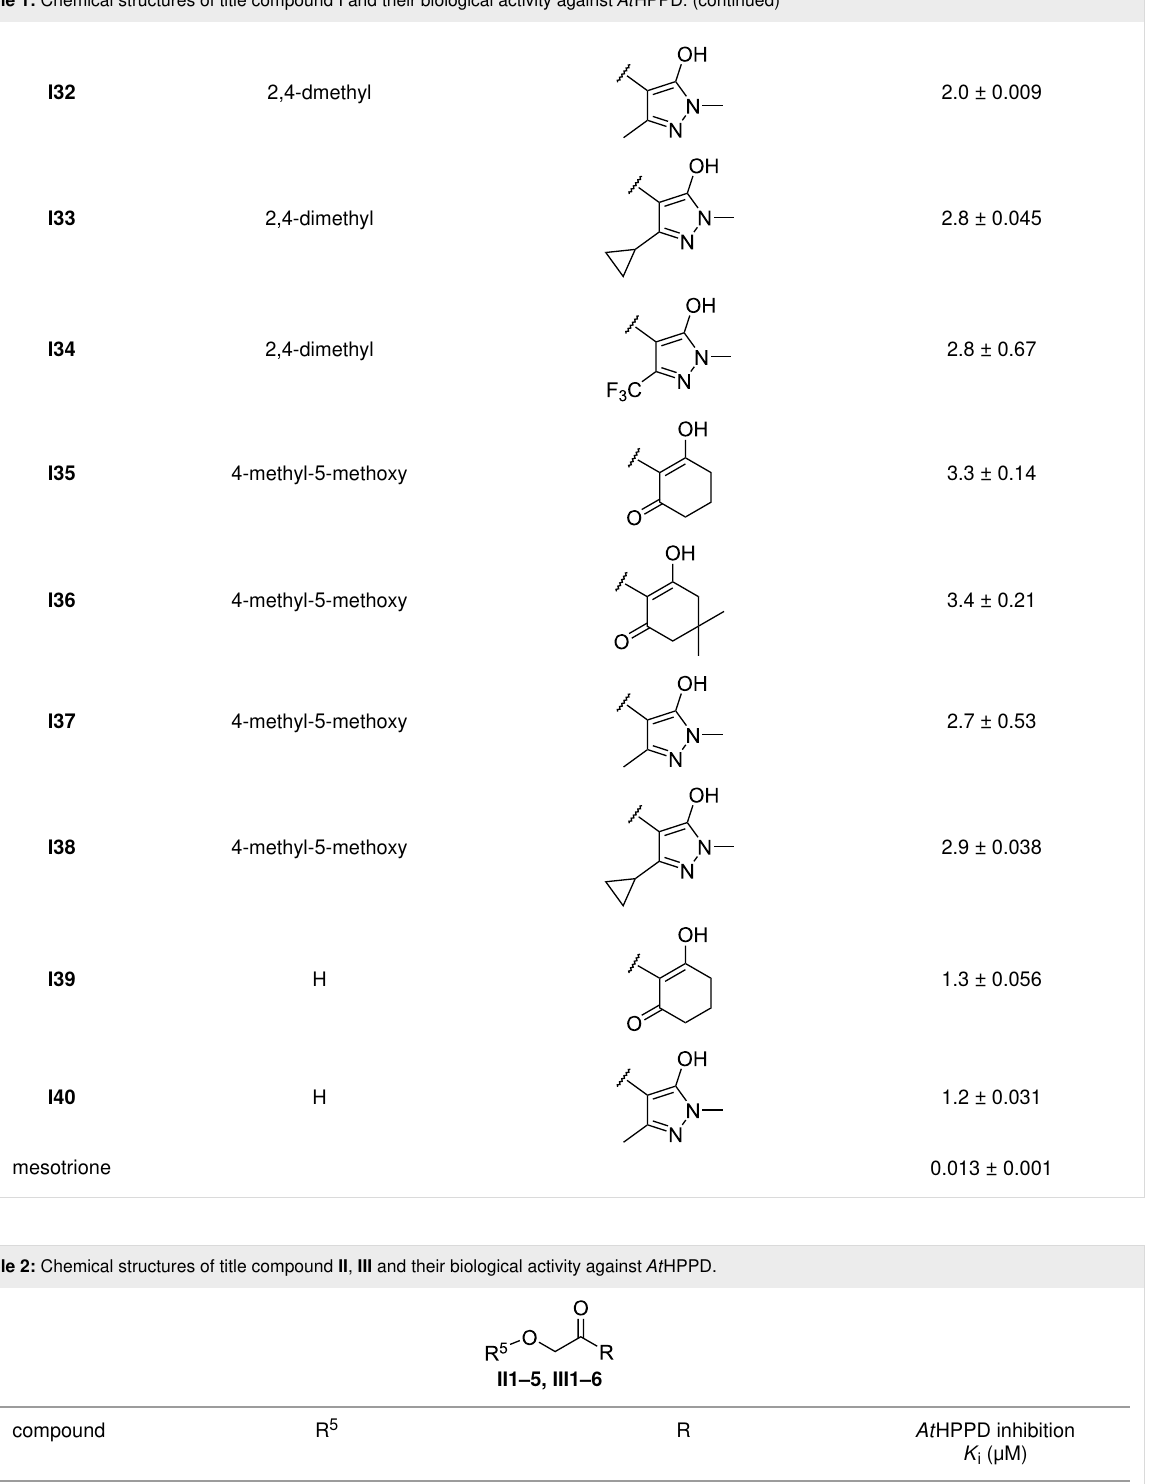
Table 1: Chemical structures of title compound I and their biological activity against At HPPD. (continued)